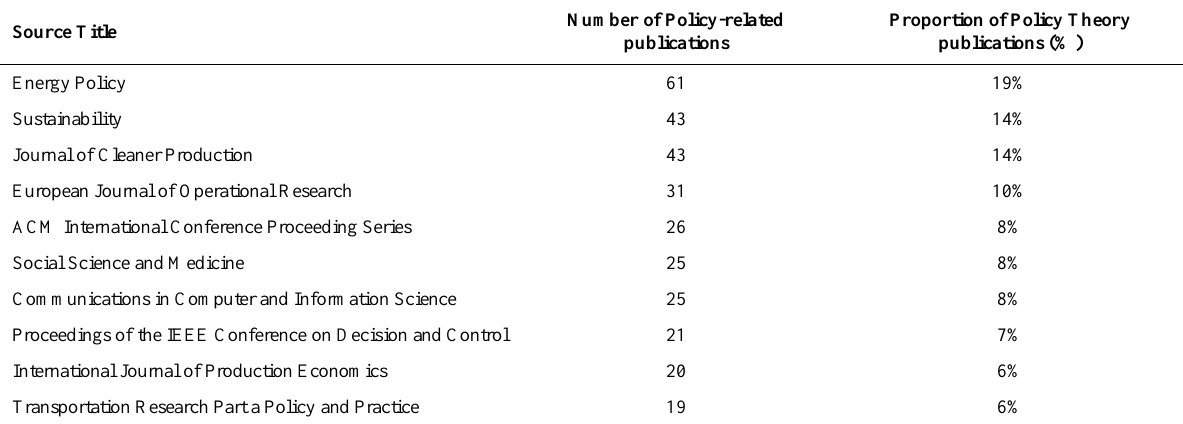
Table 2. Theory-related policy research publications on different international journals (selected list).